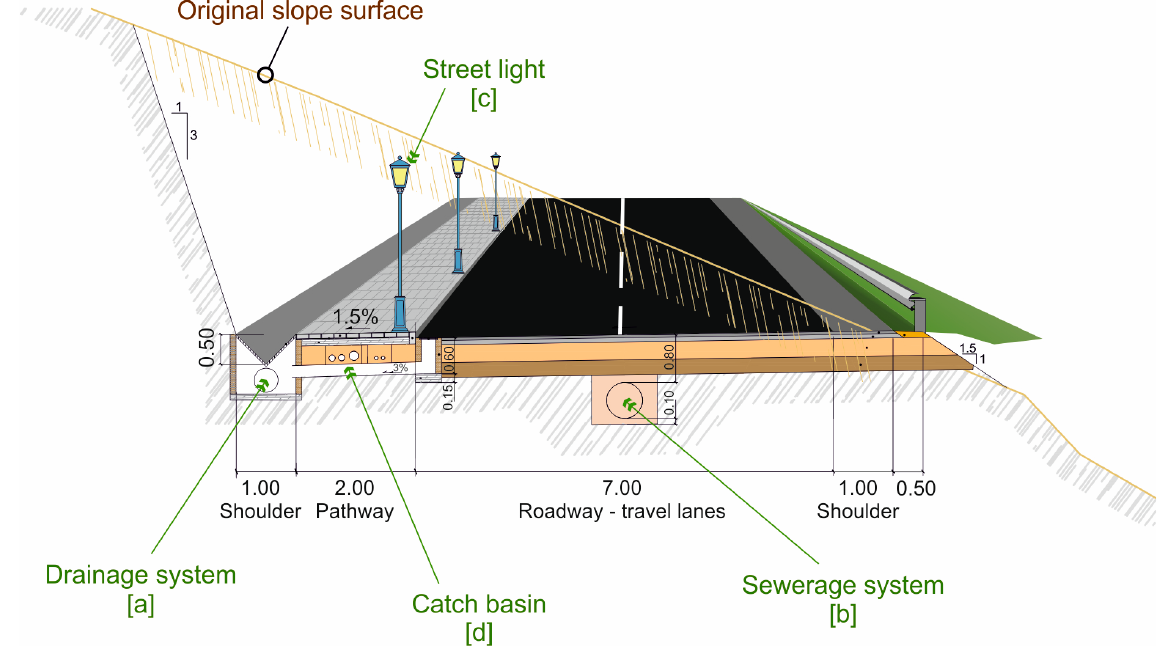
Figure 2. Section of the road.